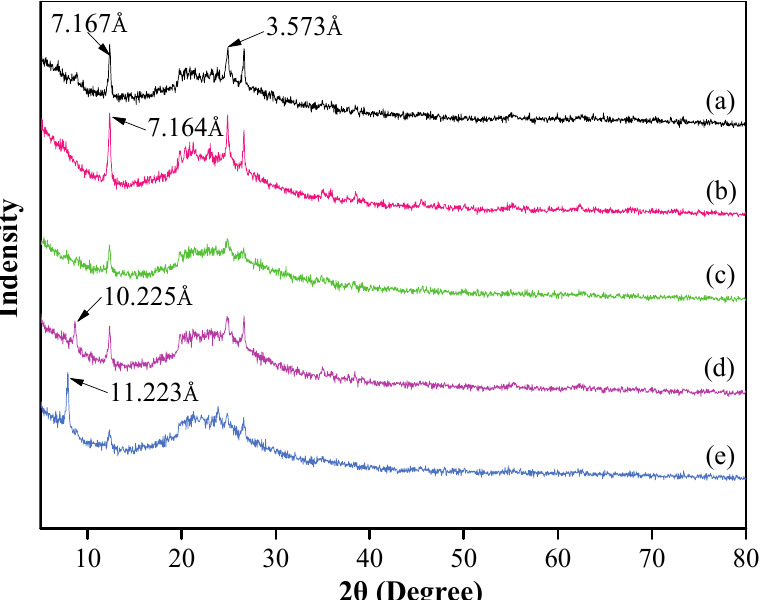
Table 2. Composition of the original kaolinite and the acidified kaolinite.